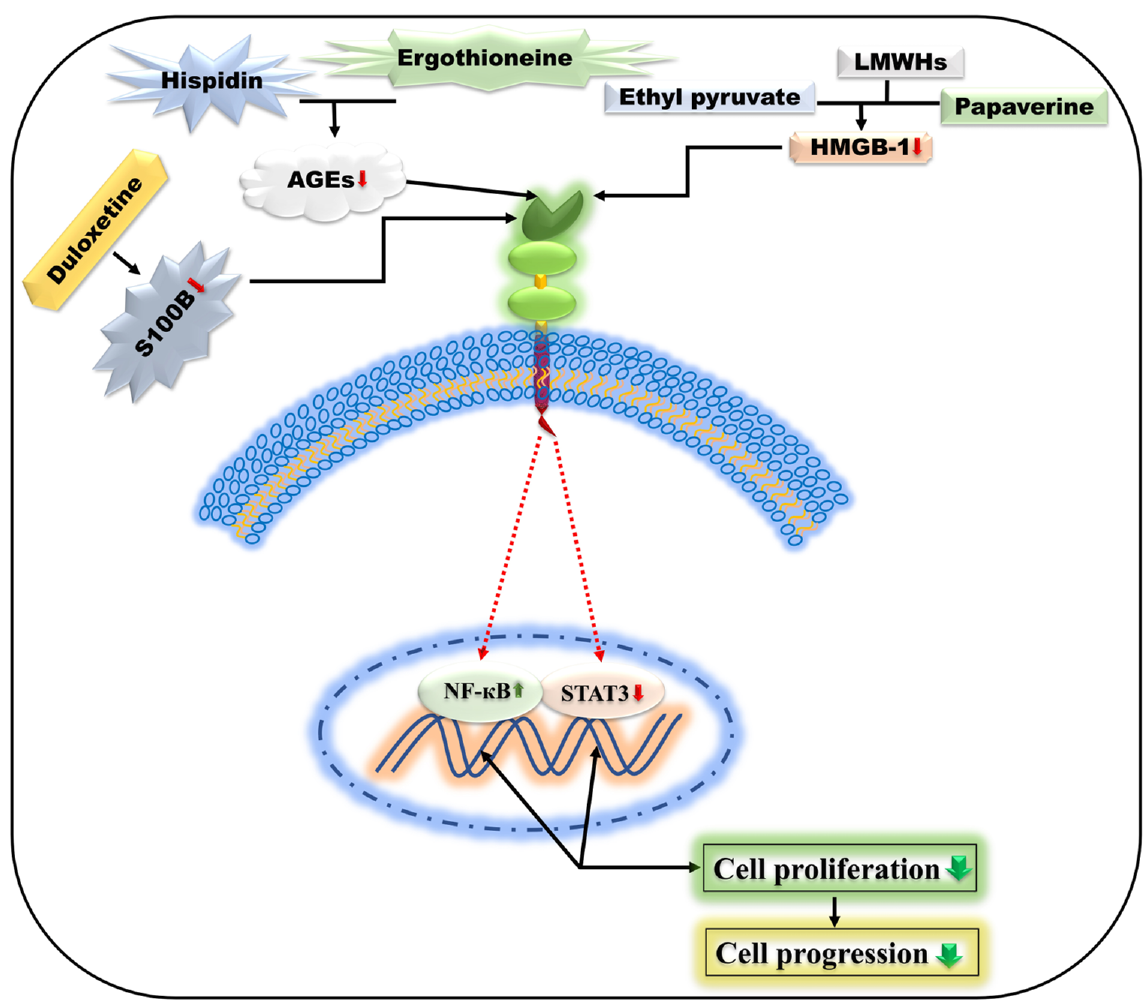
Figure 5. RAGE inhibitors such as duloxetine, hispidin, ergothioneine, ethyl pyruvate low-molecular-weight heparins (LMWHs), and papaverine diminish the formation of AGEs, S100B, and HMGB1 and have an impact on downstream signaling (red arrow in downward direction). However, these inhibitors upregulate NF- κ B (green arrow upward direction) and downregulate STAT3 (red arrow downward direction) which are primarily involved in the regulation of cancer progression. Moreover, another green arrow indicates the suppression of cancer progression (green arrow in downward direction).